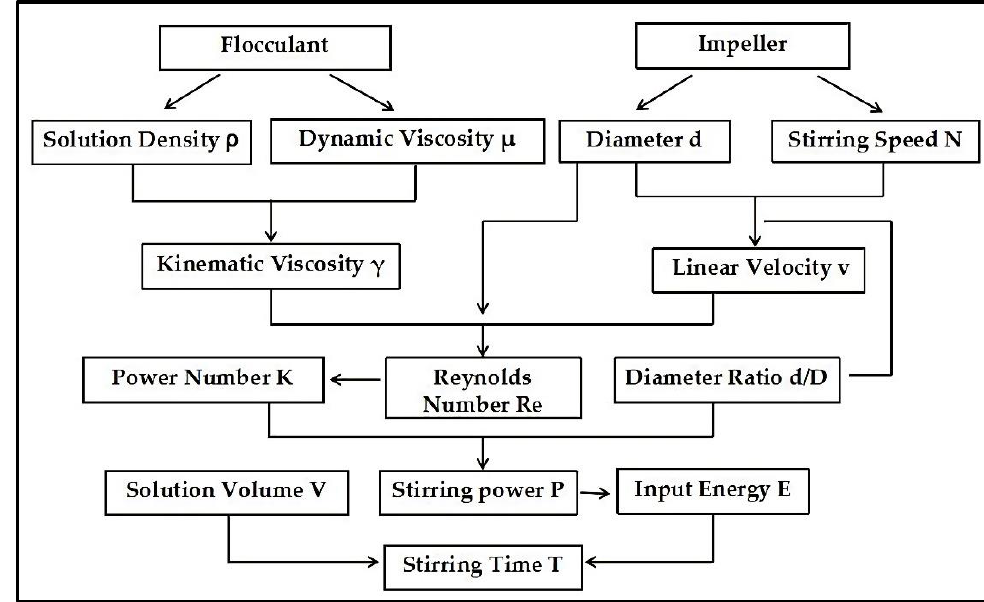
Figure 12. Flocculant dissolution — stirring time derivation method.